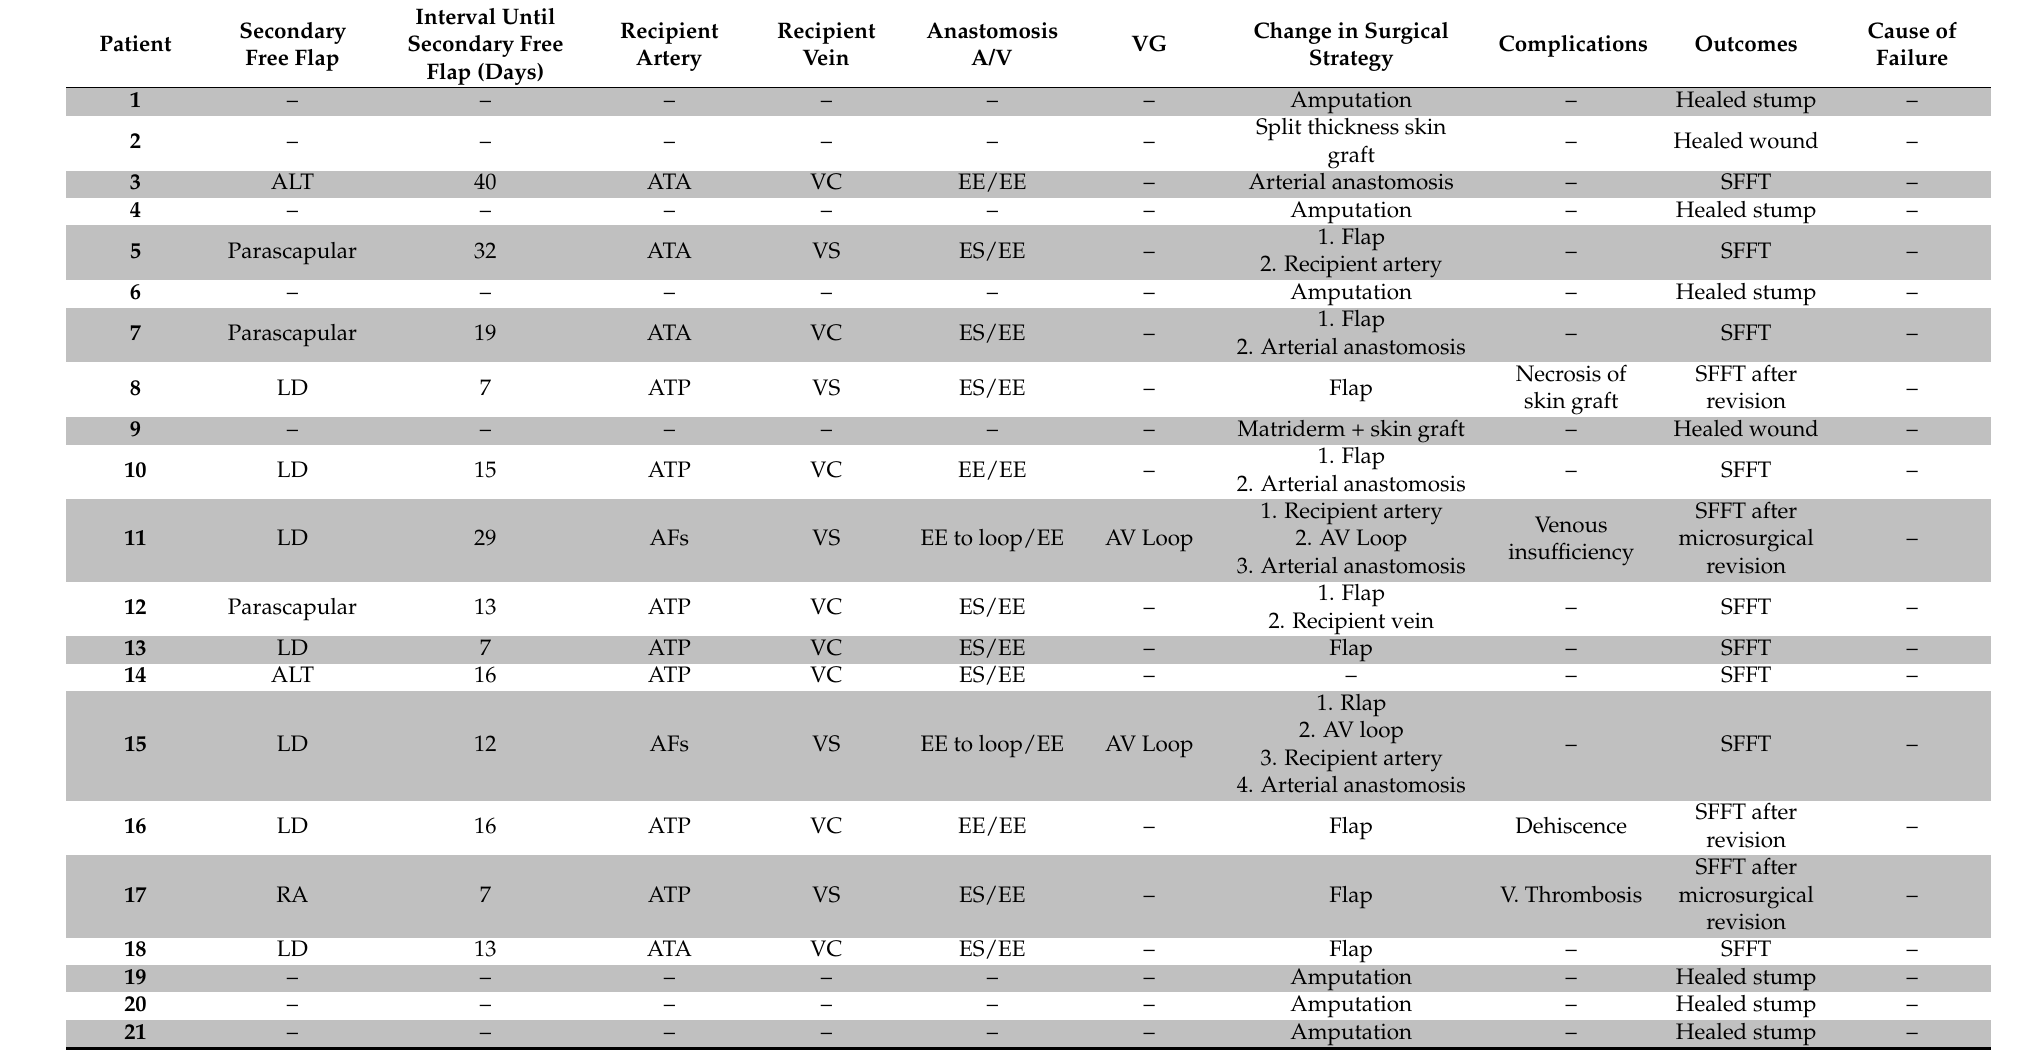
Table 3. Surgical strategy for secondary